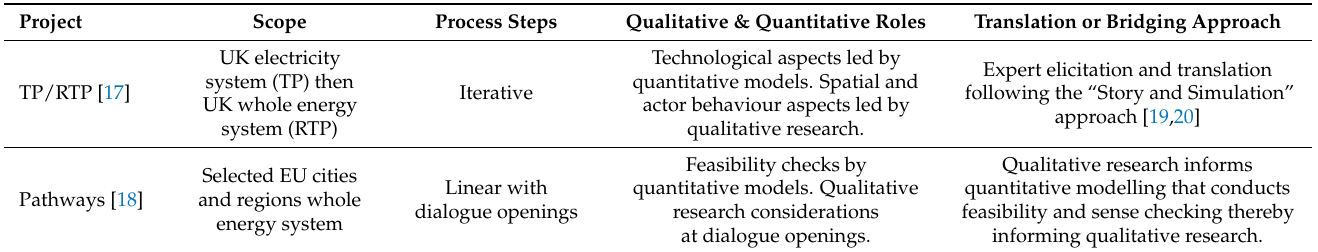
Table 1. Summary features of the TP/RTP and Pathways